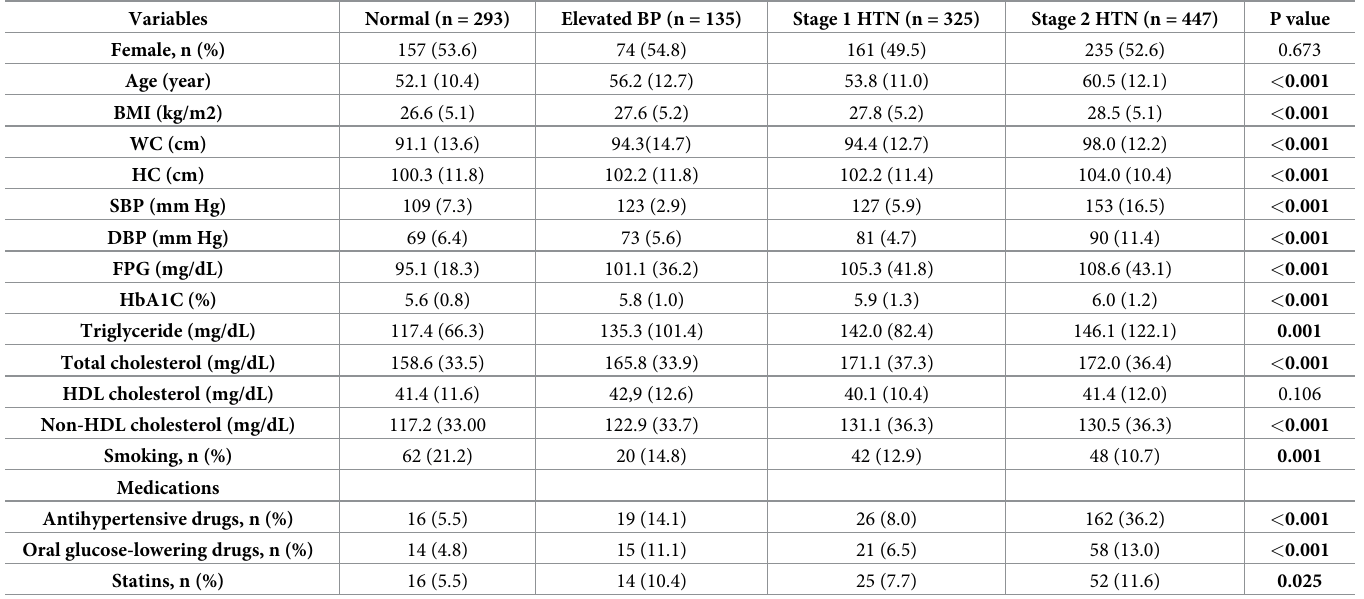
Table 1. The demographic and clinical characteristics of participants in different blood pressure